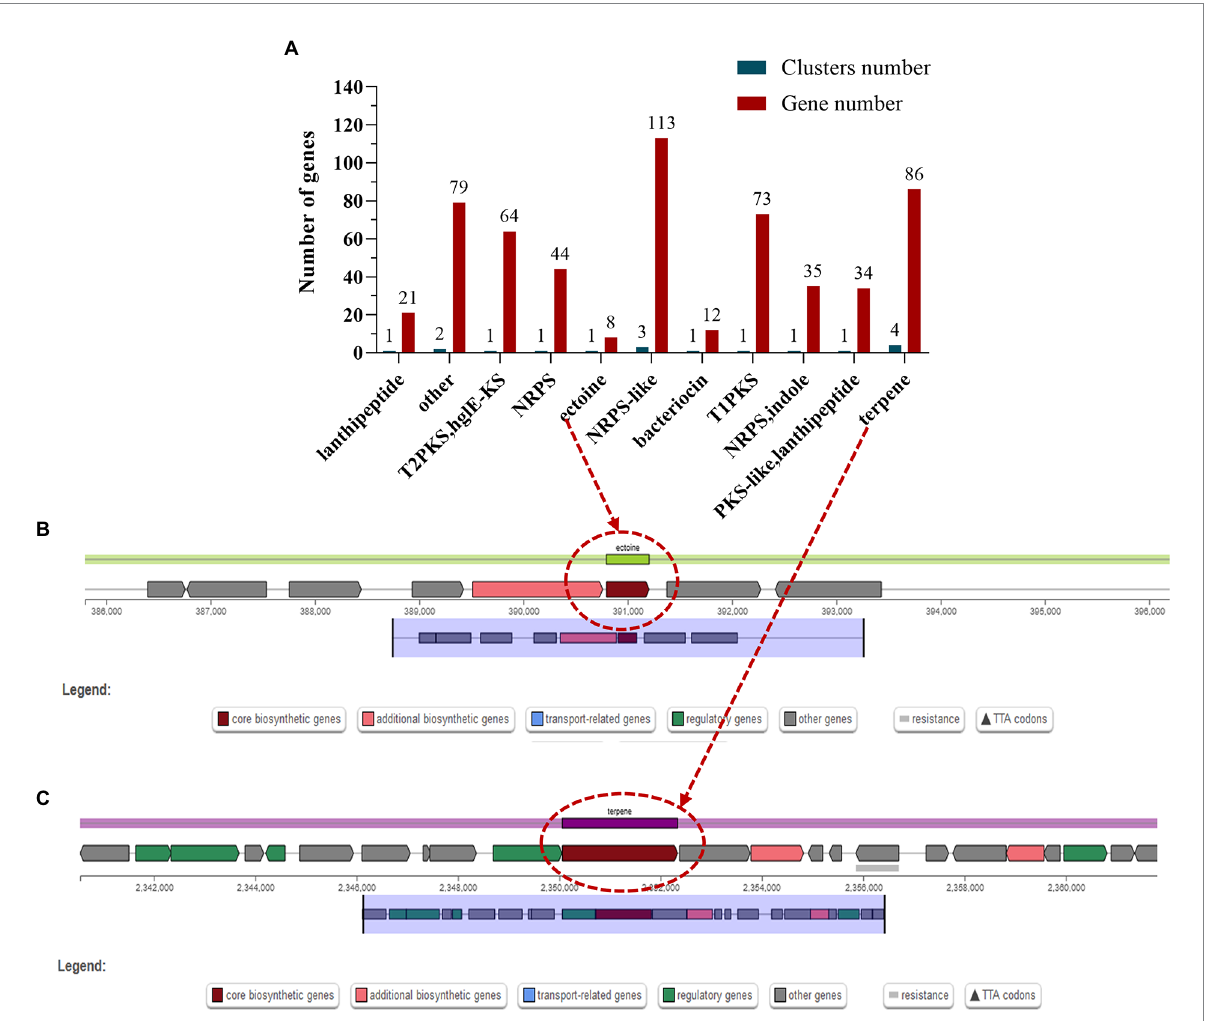
FIGURE 4 Classification statistics (A) of the secondary metabolite biosynthesis gene clusters in the S. rosea A22 genome and the chromosomal location of the key secondary metabolites ectoine (B) and terpene (C)